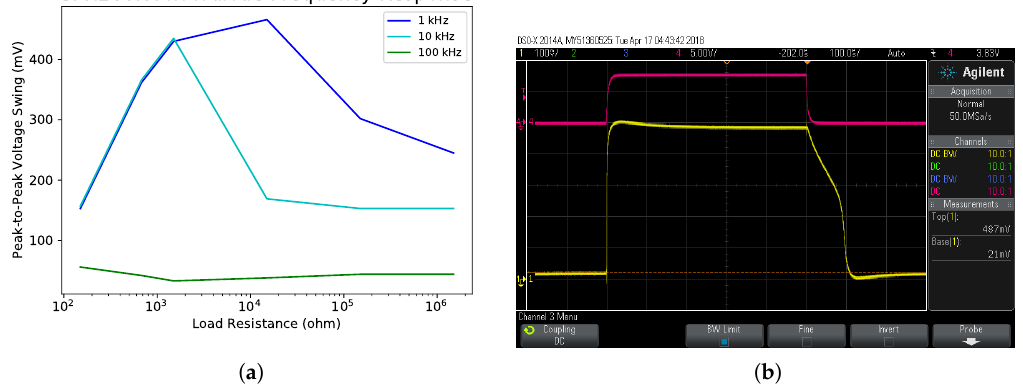
Figure 5. Measured AC response of a SFH206K photodiode illuminated by a 5 mW laser at 2 cm. ( a ) The peak-to-peak voltage swing varies with both frequency and load resistance. In this data, 1 kHz switching and 15 k Ω load resistance yields the highest peak-to-peak swing. ( b ) The laser input (red on top), and the photodiode output voltage transient (yellow on bottom) with 15 k Ω . The falling edge is relatively slow because it takes a long time to drain the diffusion capacitance through the load